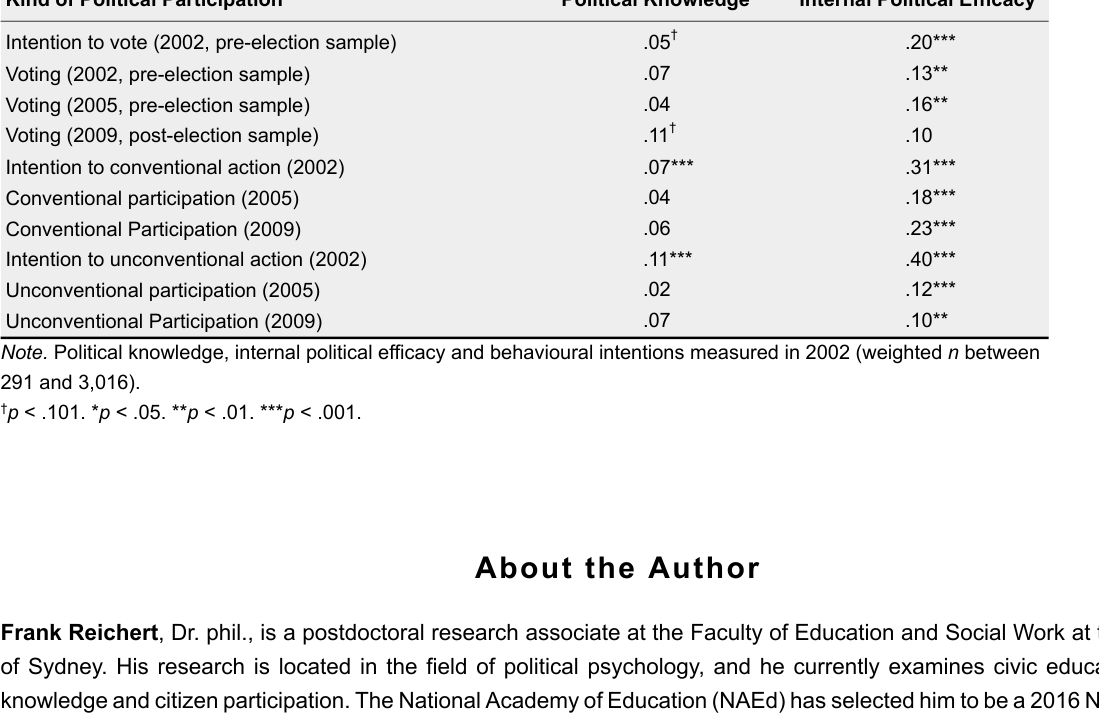
Internal Political EfficacyPolitical KnowledgeKind of Political Participation